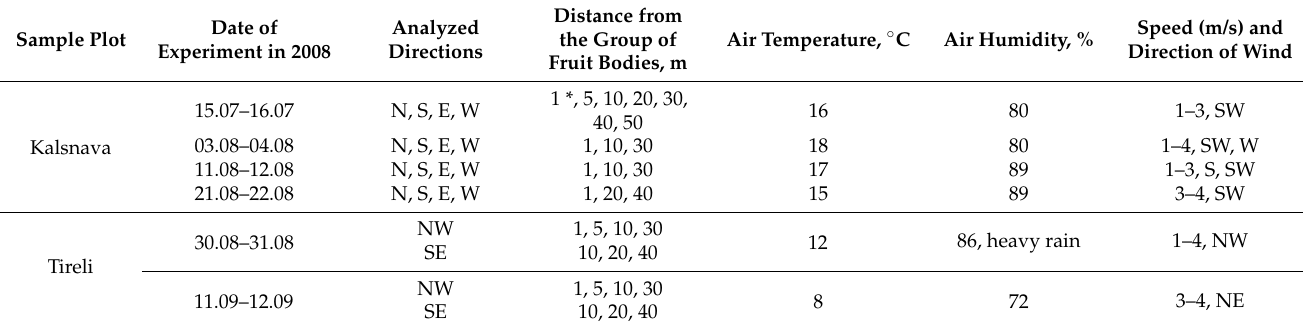
Table 1. Main features and experimental conditions of sampling campaigns of airborne Heterobasidion annosum s.l. spores in Kalsnava and